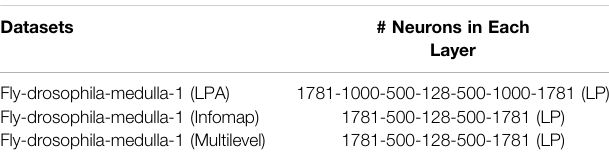
TABLE 8 | Detailed architecture information for datasets ( DANRL-CA/LPA/ Infomap/Multilevel ).